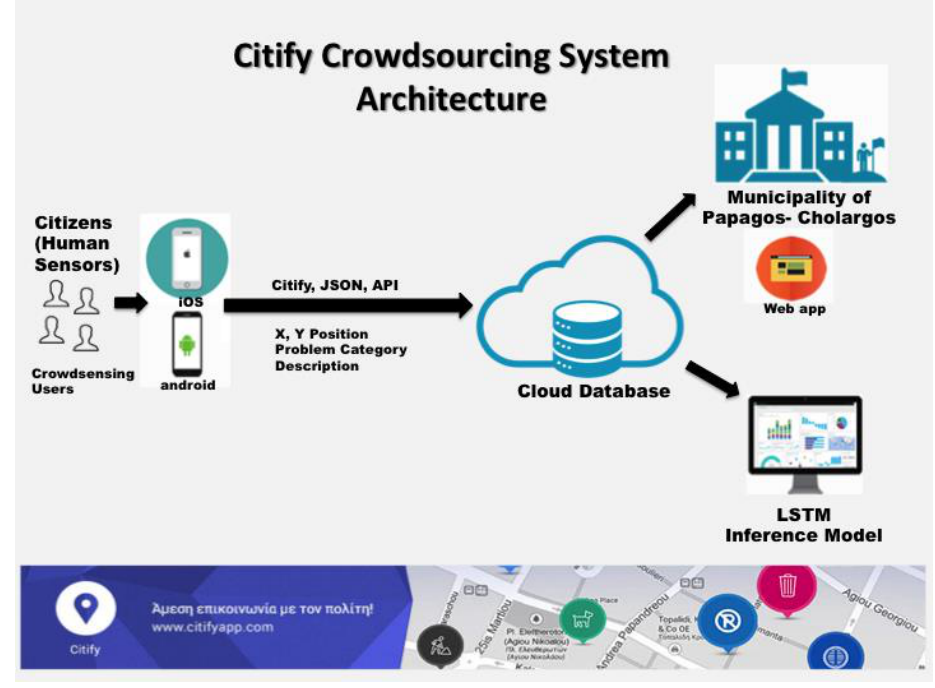
Figure 4. Proposed crowdsourcing system architecture.